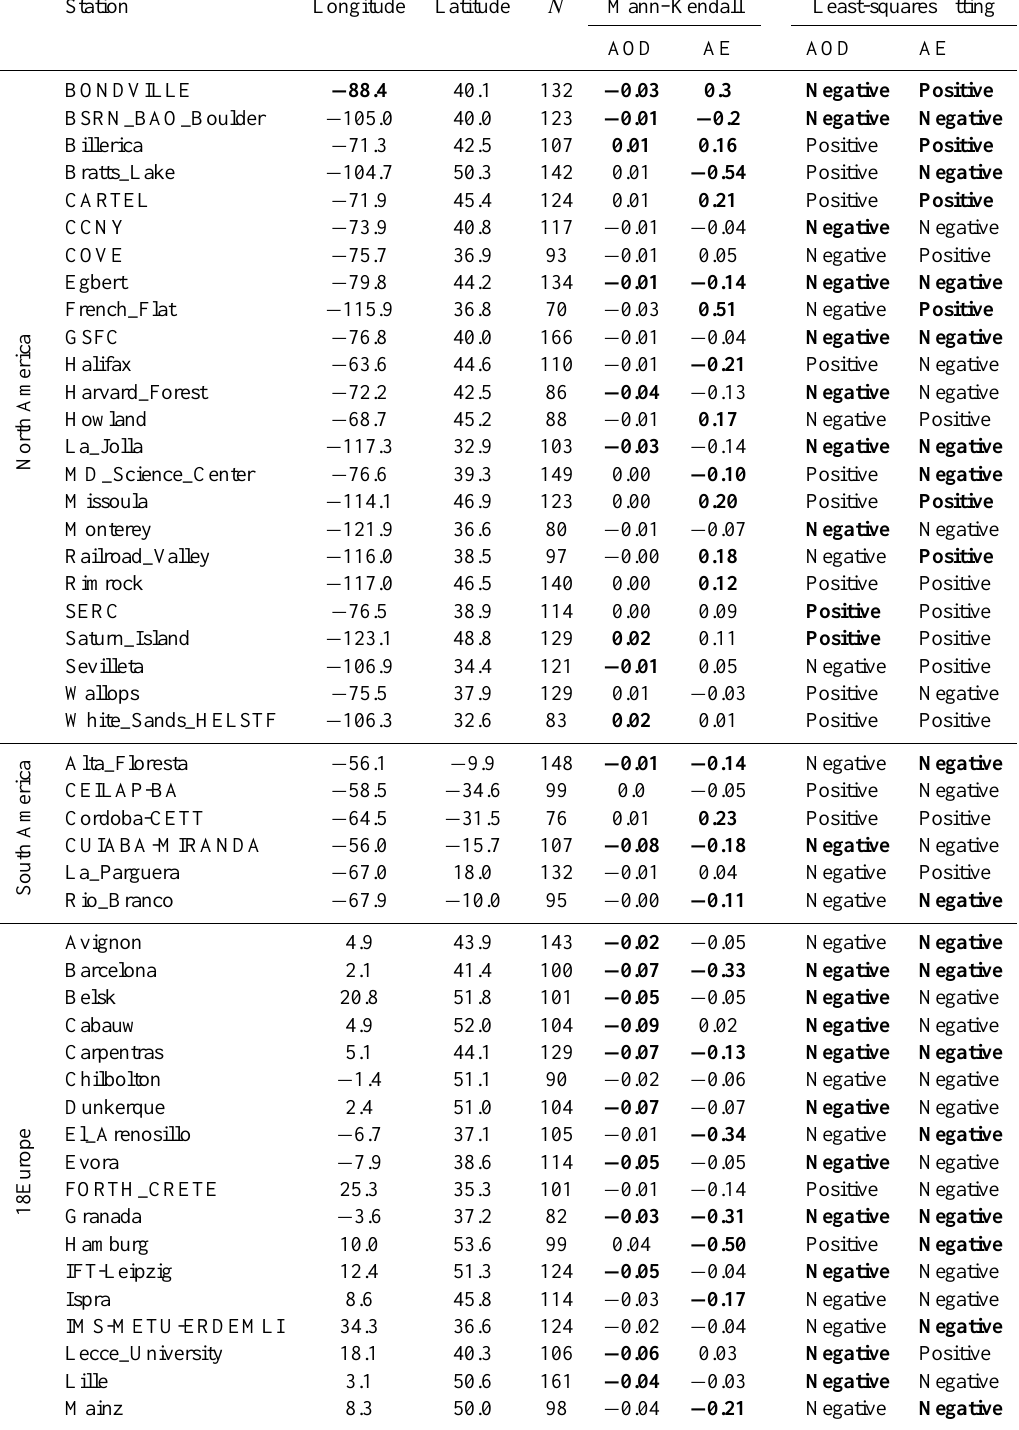
Table 1. Location, aerosol type, number of months used in the analysis ( N ), and trends (decade) for 440nm AOD and AE at the 90 selected stations. Bold values indicate trends at 90% significance level. For least-squares fitting, as the logarithm of some parameters are used, the trends are only indicated by positive or